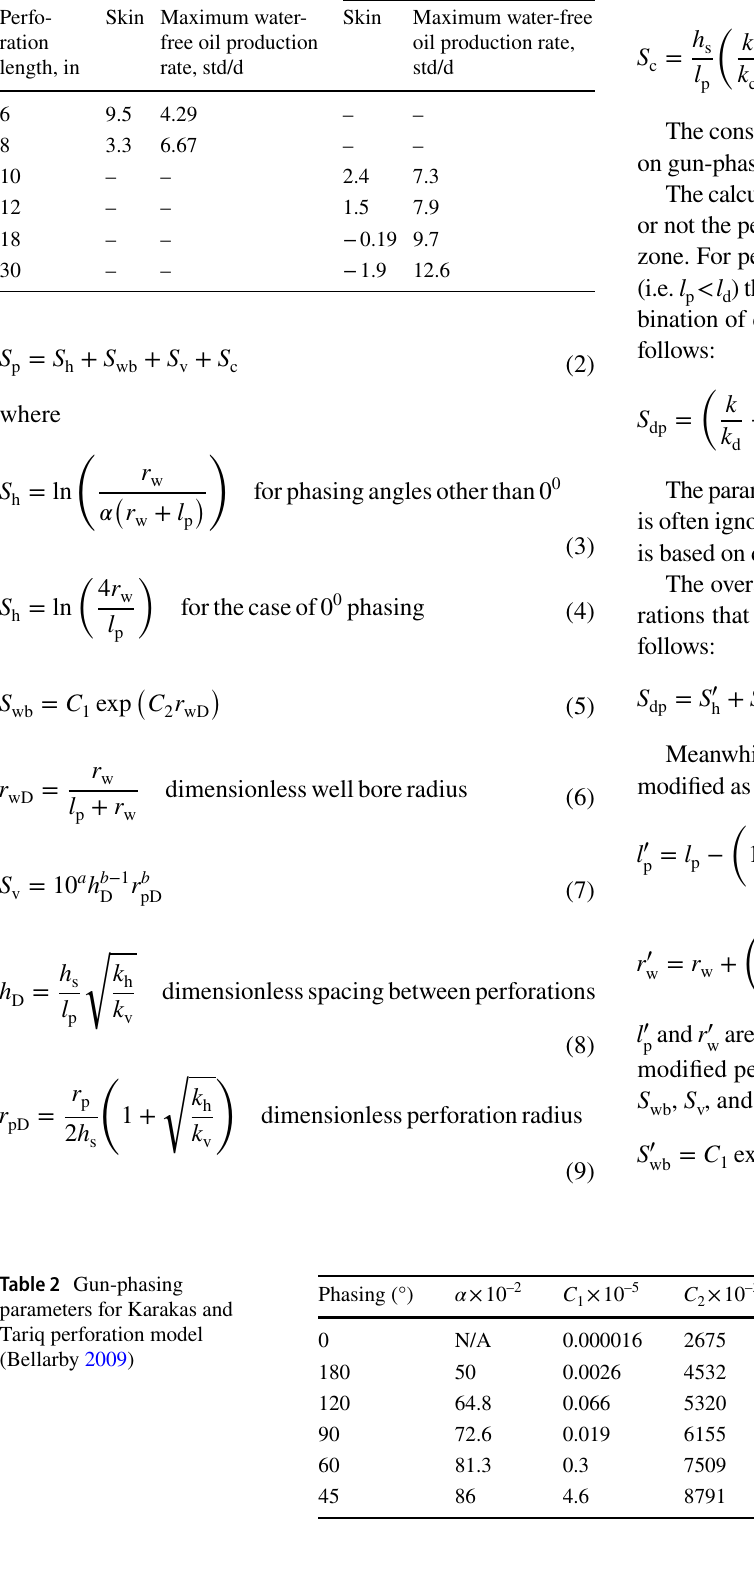
Table 1 Overall skin to perforation length test at perforation done within and beyond damaged zones Perforation within dam- aged zone Perfo- ration